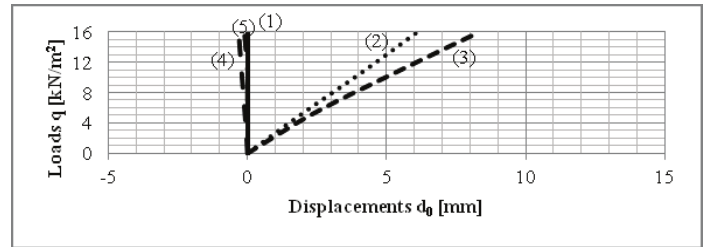
Fig. 7b. Displacements d 0 (mm) depending on the use of sheet piles as a cover of the foundation. Horizontal load applied on the backfill of road embankment